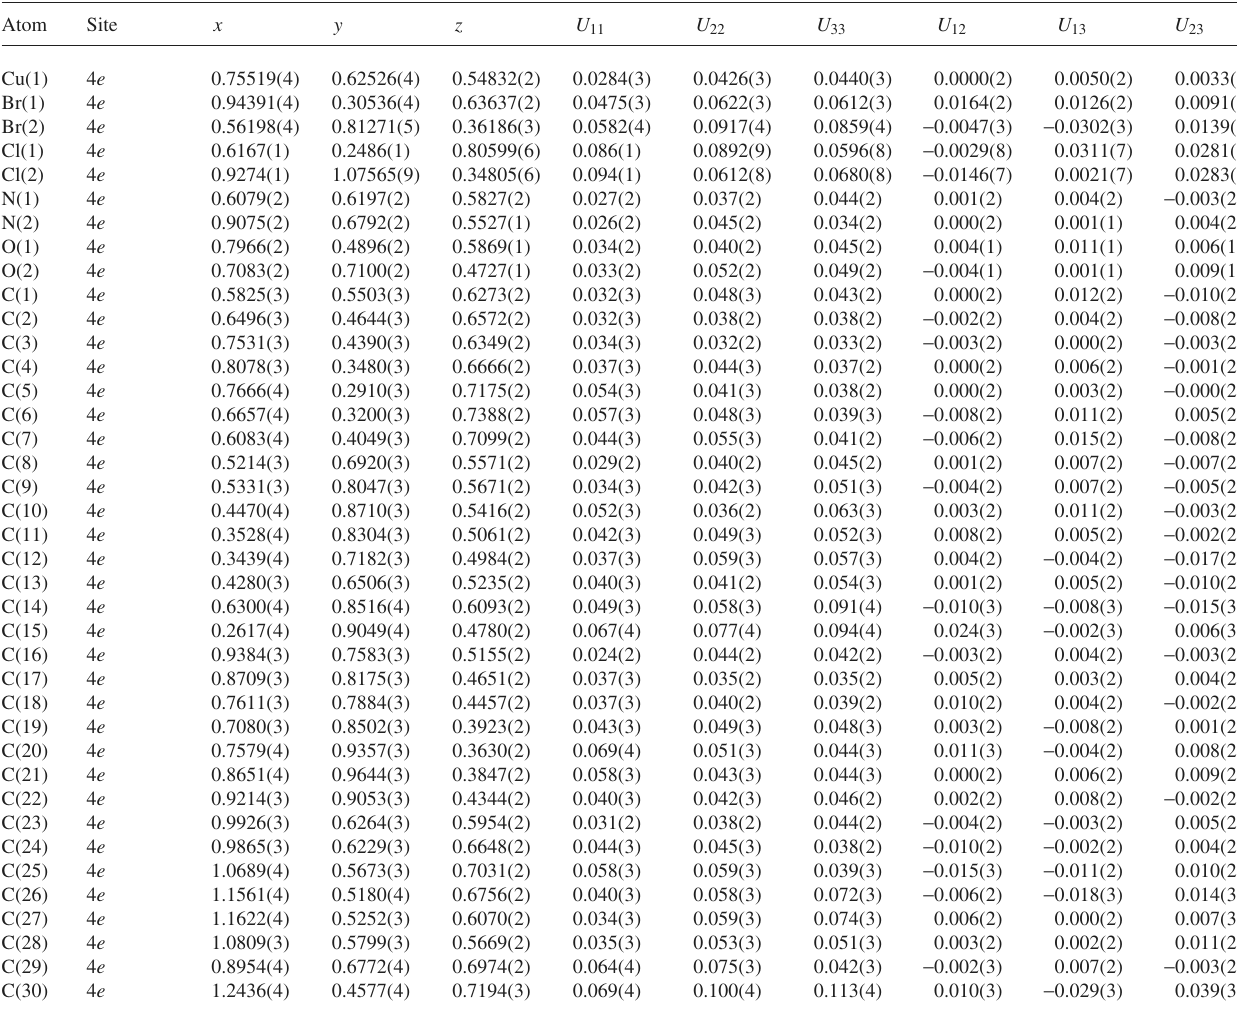
Table 3. Atomic coordinates and displacement parameters (in Å 2 )